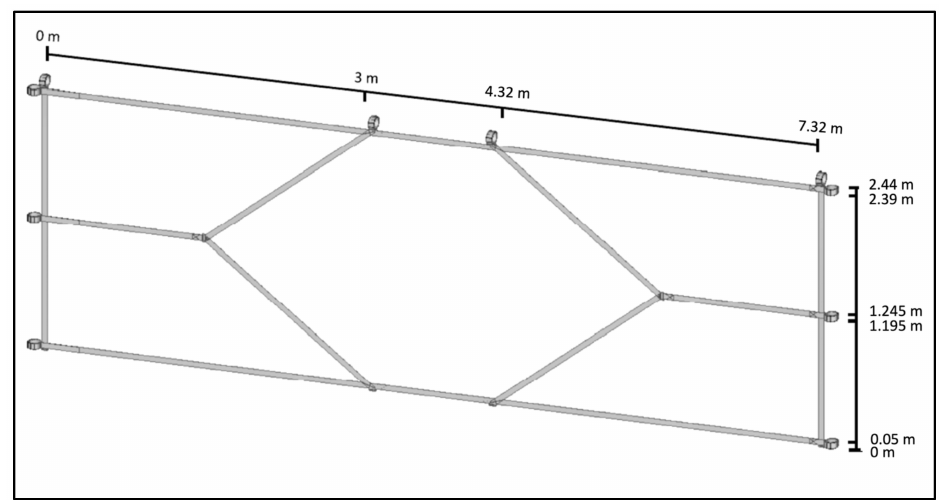
Figure 1. Target net which is attached to the posts and the crossbar of the